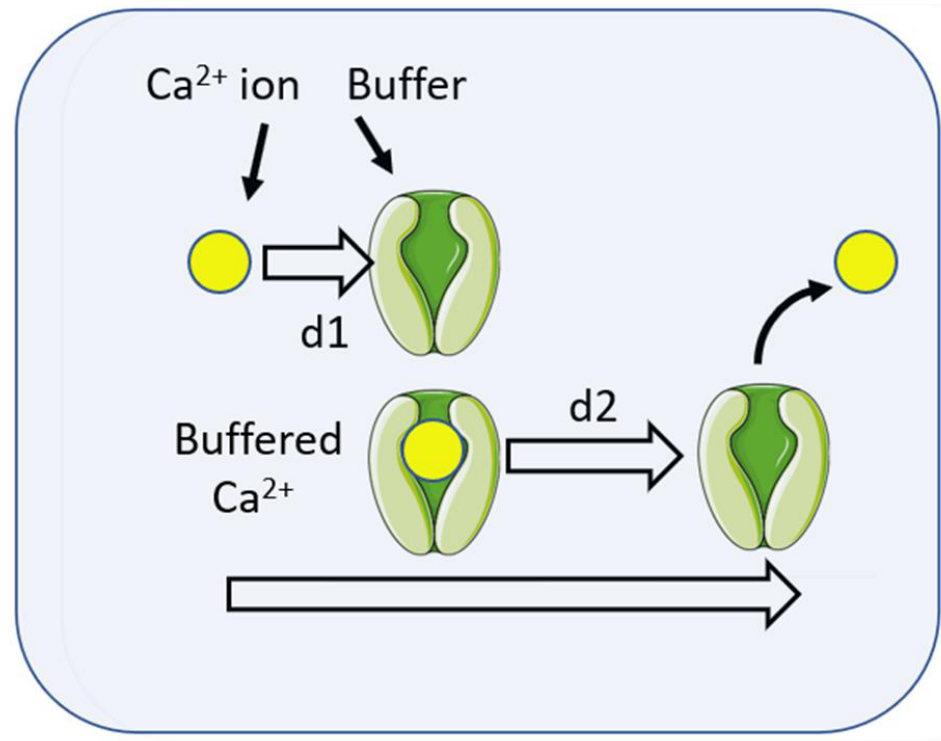
Figure 2. The Effect of Ca 2+ buffering on diffusion length (signalling reach).